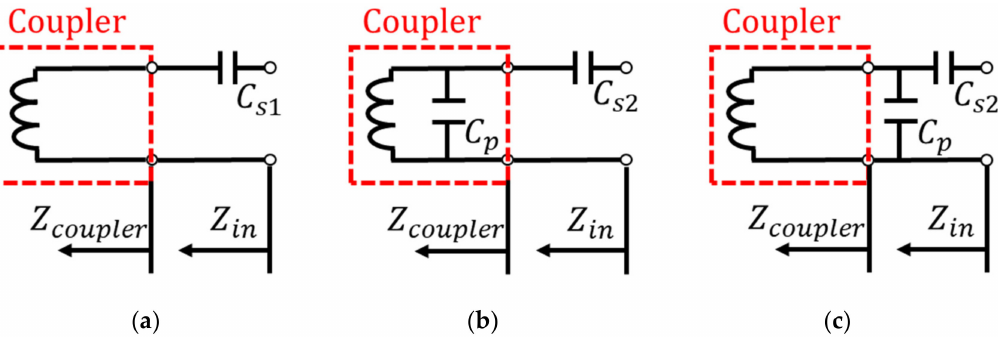
Figure 2. Equivalent circuits of di ff erent coils. ( a ) One-turn loop coil, ( b ) shielded loop coil, and ( c ) one-turn loop with